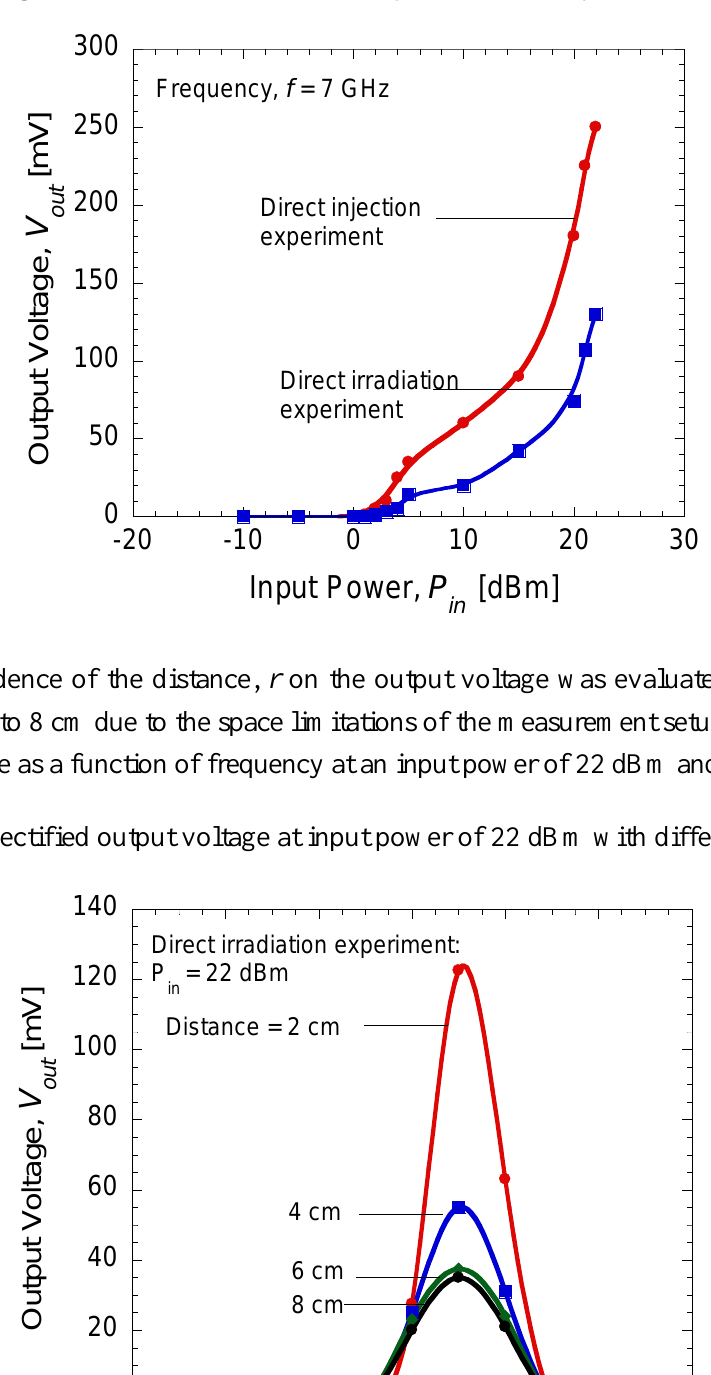
Figure 10. Rectified output voltage at a frequency of 7 GHz.